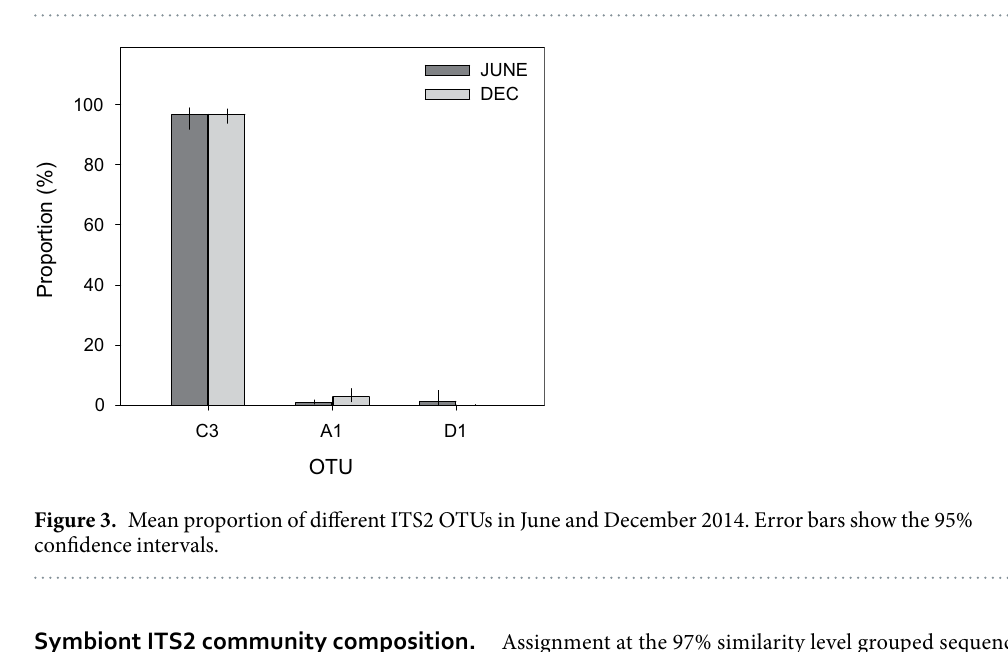
Figure 2. Incidence of bleaching among dominant taxa at two Umm Al Quwain lagoon reefs in September 2014. Only taxa that were present on more than 3 transects and with more than 10 CPCe counts are shown (Supplementary Table 2). Error bars indicate the 95% confidence intervals. PL = Platygyra , PO = Porites , CY = Cyphastrea , DI = Dipsastraea .